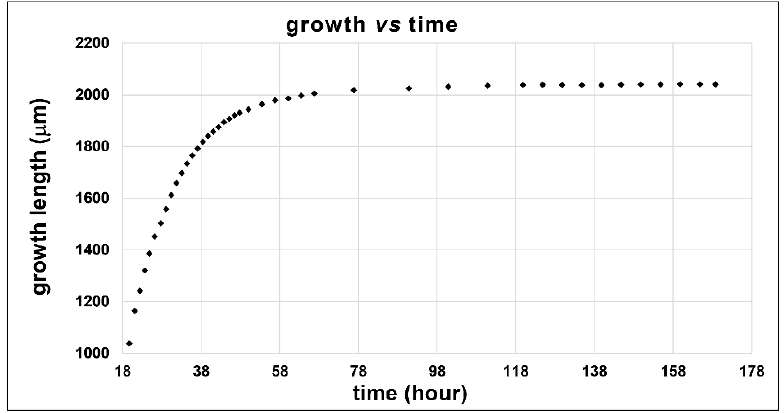
Figure 11. Measured values of the crystal size (crystal length from the tip of the crystal) plotted versus time for the middle and final stage of the growth process (20 to 168 hours, gel density 0.1 w / v %). Only some selected experimental data points have been reported for clarity. The crystal reconstruction seems to start about 40 hours after the experimental start-up (see also Figure S9).